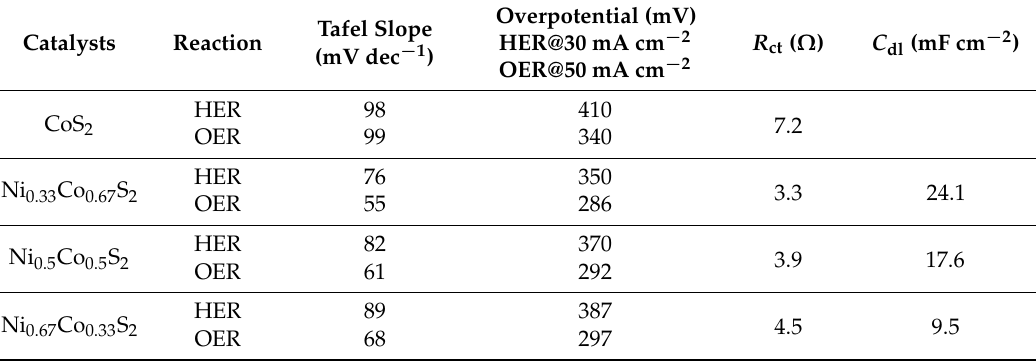
Table 1. Summary of the electrochemical activities of Ni x Co 1 − x S 2 NN/SS electrodes with different Ni/Co